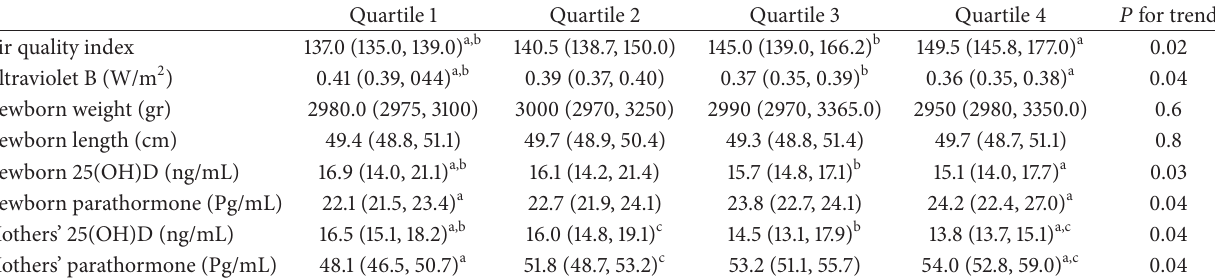
Table 2: Variables studied according to the quartiles of the air quality